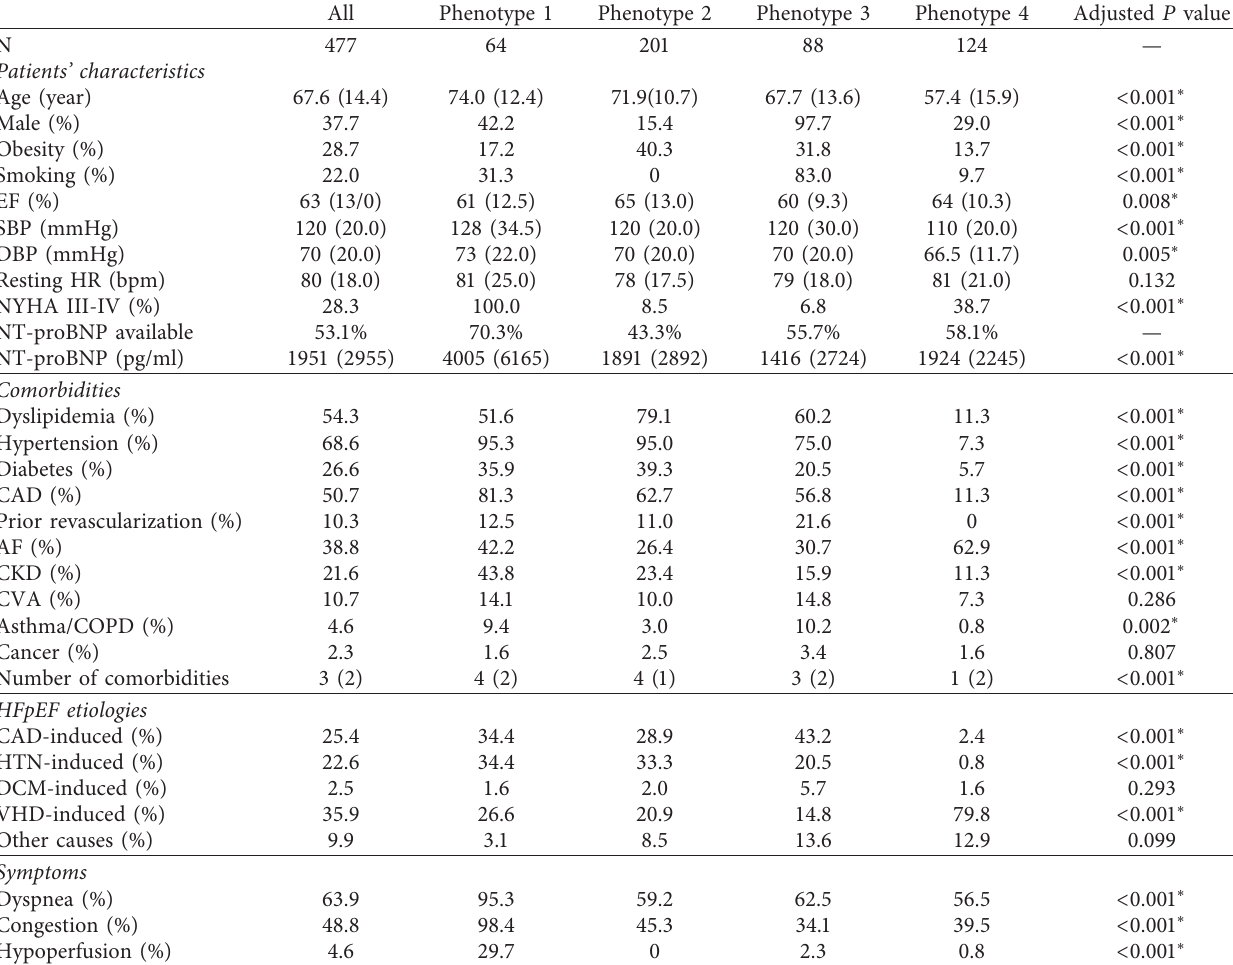
Figure 1: Pie chart showing the number of comorbidities: total, cardiovascular (CV), and noncardiovascular. Table 1: Four clinical phenotypes of patients diagnosed with